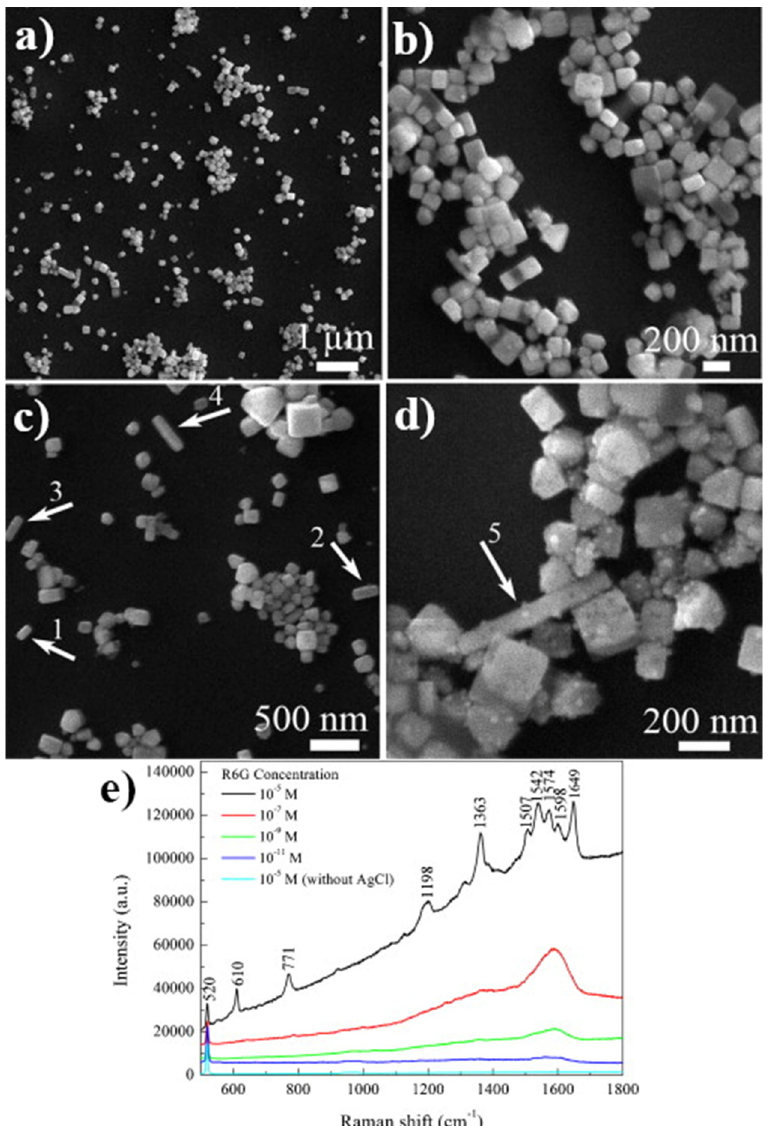
Figure 12. ( a – d ) SEM images of the AgCl nanoparticles produced by laser ablation, ( e ) SERS spec- tra of molecules of rhodamine 6G on AgCl nanoparticles adsorbed from solutions with various concentrations. Reprinted with permission from [64]. Copyright 2012 Elsevier.